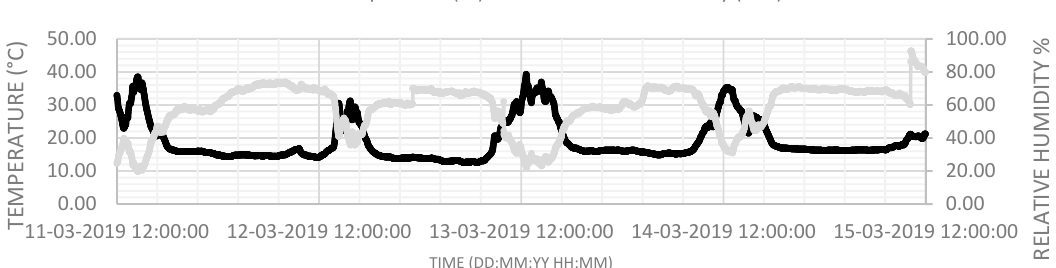
Figure 13. Measured temperature and relative humidity in the second week.